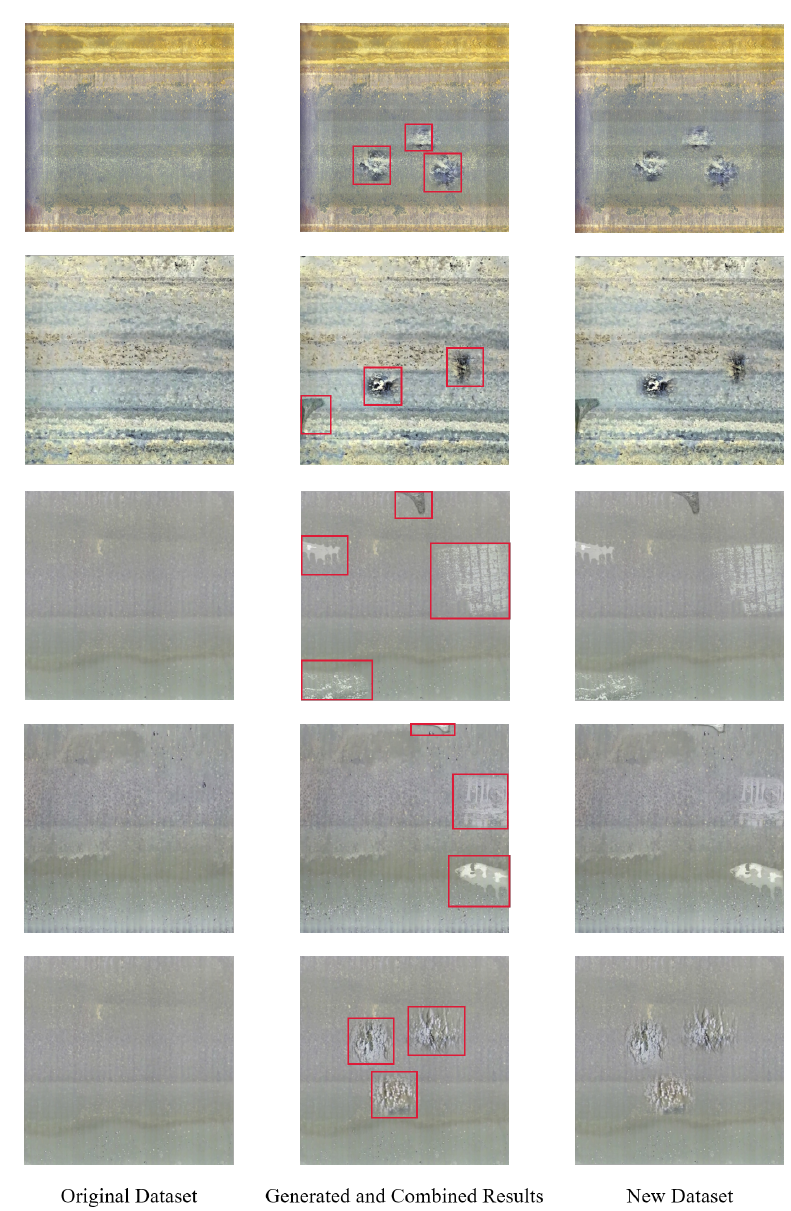
Figure 12. The original images and the fusion